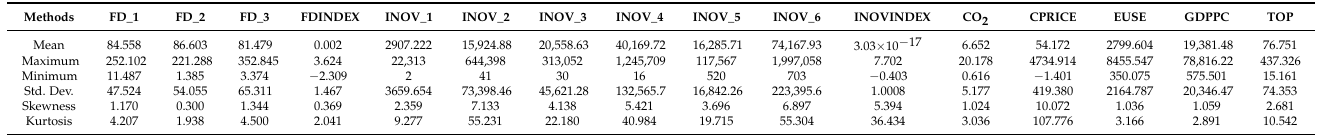
Table 4. Descriptive Statistics.